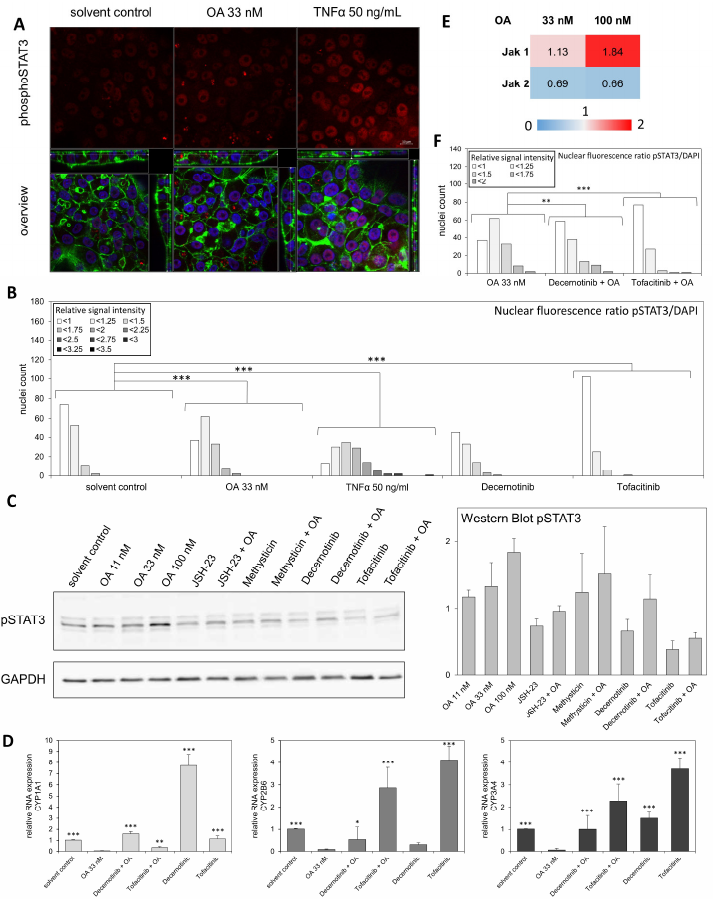
Figure 5. Activation of JAK/STAT signaling in HepaRG cells after exposure to OA. Differentiated HepaRG cells were treated with 33 and 100 nM OA alone or 33 μM OA in combination with 40 μM Decernotinib, or 40 μM Tofacitinib, two JAK activation inhibitors or with the respective solvent control for 24 h. ( A ): Nuclei were stained with DAPI, and the actin cytoskeleton was stained using